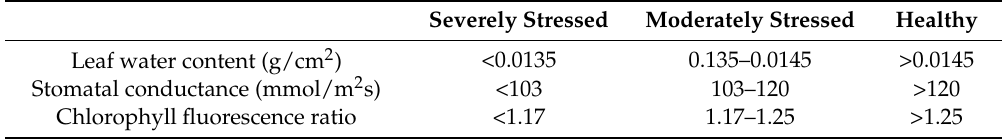
Table 3. Stress level categories classified using the range of the leaf traits (leaf water content,